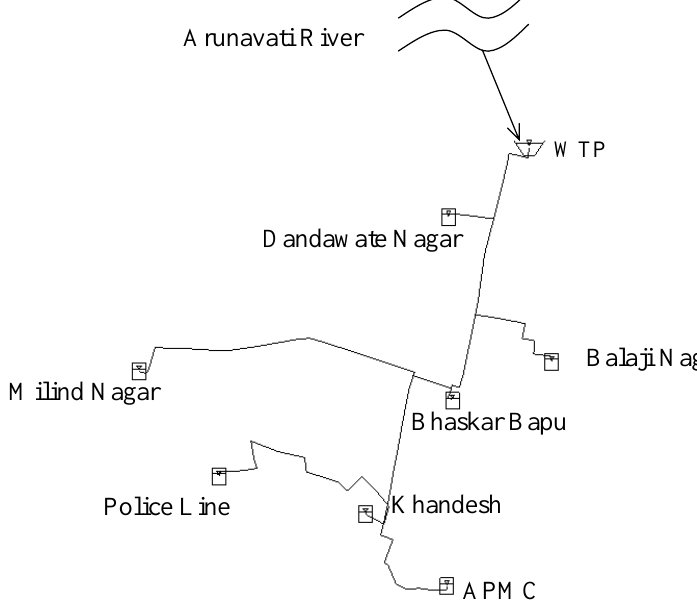
Fig. 1. Water supply system in normal